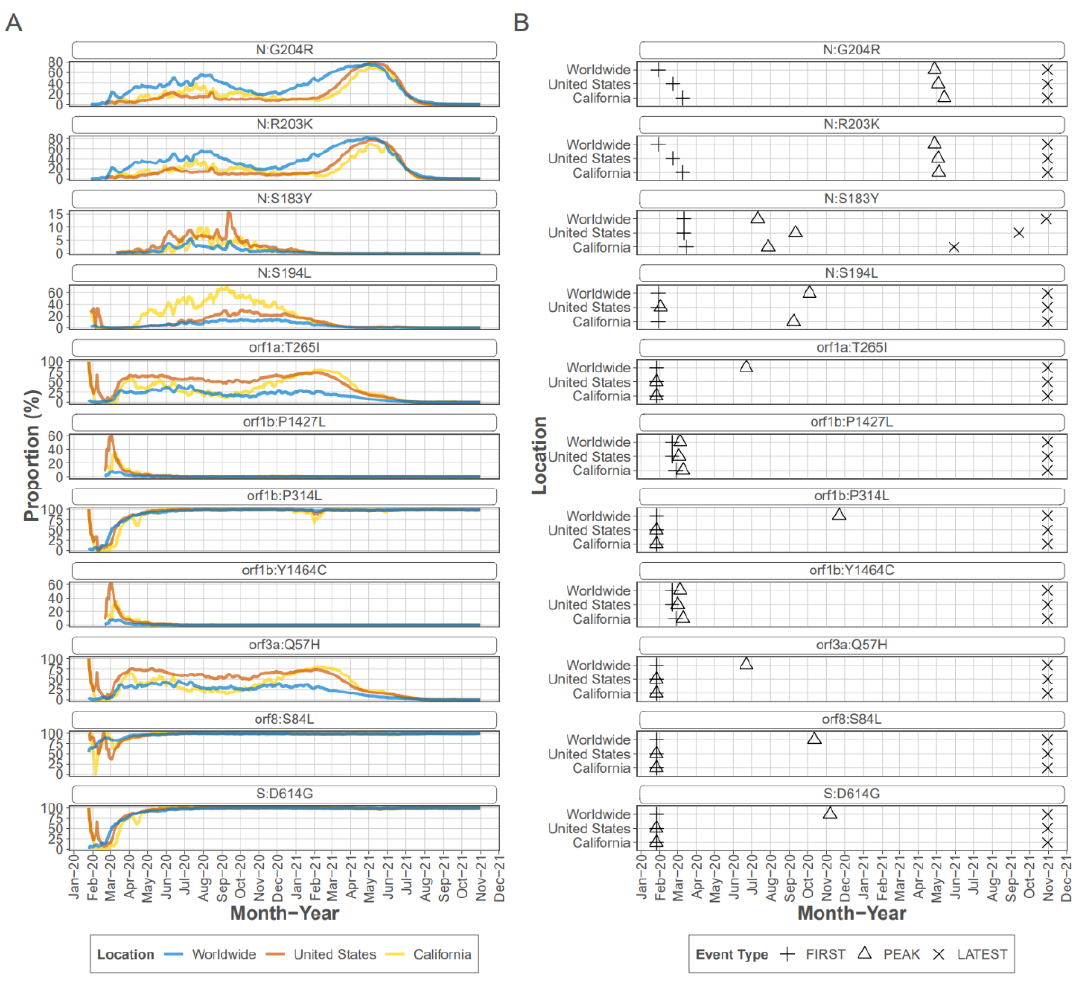
Figure 2. Emergence, prevalence, and duration of highly ranked mutations. ( A ) Prevalence of top-ranked mutations over the course of the pandemic. Each graph represents the 7 day rolling average of the percent positive sequences for each mutation (data obtained from outbreak.info with analysis period through 31 October 2021). ( B ) Emergence, peak and duration of highly ranked mutations. Graphs show for each mutation the date the mutation was detected, the date it reached peak prevalence, and the date last detected. Mutations are considered to be persistent when they are still detected in 1 November 2021, the latest date sequence data available through outbreak.info were analyzed for this